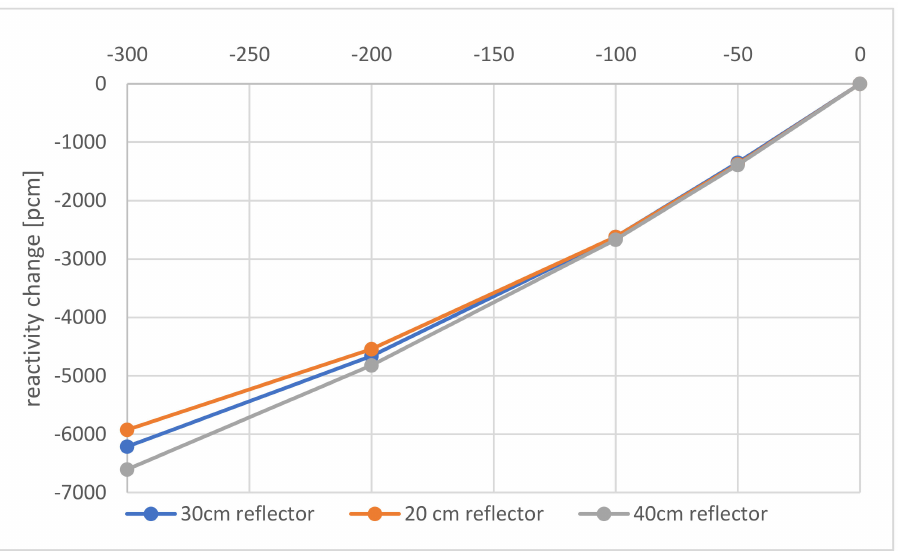
Figure 15. Shutdown reactivity from the critical state for systems with different reflector and system